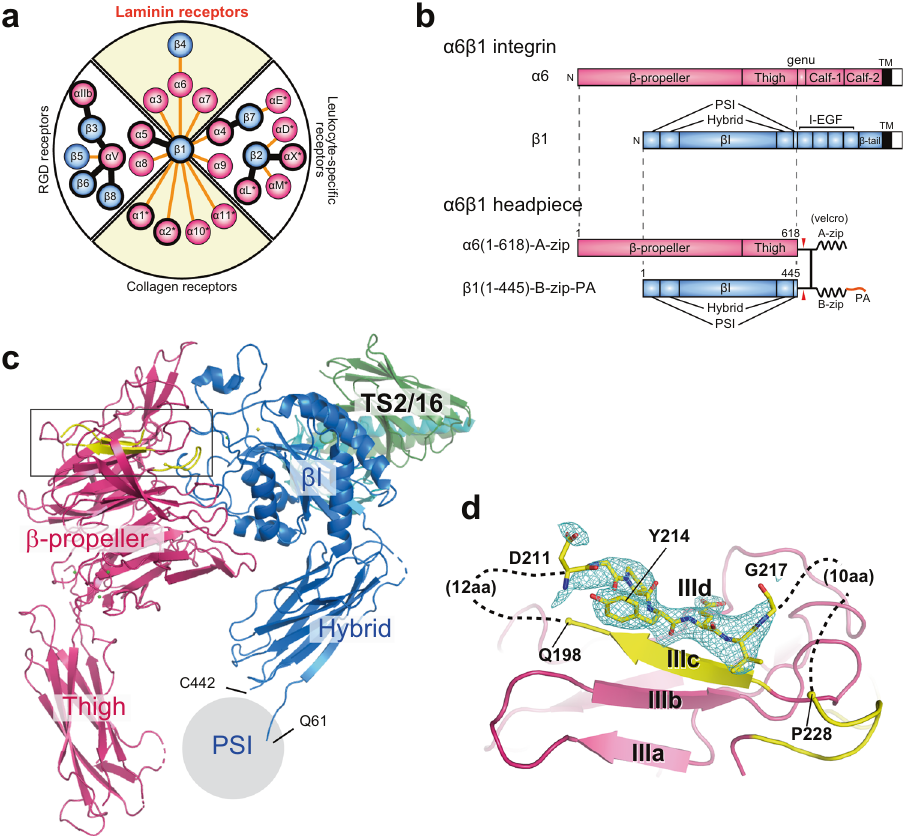
Fig. 1 Crystal structure of the α 6 β 1 integrin headpiece in complex with TS2/16 Fv-clasp. a Integrin α / β pairs and classi fi cation. 18 α subunits (red circles, with the α I domain-containing ones indicated by asterisks) and 8 β subunits (blue circles) found in human forming 24 heterodimeric pairs are represented by the α - β connecting lines. Integrin subunits or heterodimers with at least partial ectodomain structures determined are denoted by thick circles. Each heterodimer falls into one of the four distinct classes. Modi fi ed from the Fig. 1 of ref. 1 . b Domain organization of α 6 β 1 integrin and design of the α 6 β 1 headpiece construct used for the structural analysis. c Ribbon presentation of the overall structure. Integrin α 6 and β 1 subunits are colored in hot pink and sky blue, respectively, and TS2/16 V H -SARAH and TS2/16 V L -SARAH composing TS2/16 Fv-clasp are in green and cyan, respectively. The location of the PSI domain (not included in the model) is denoted by gray circle, with the boundary residues (Q61 and C442) labeled. d An expanded view of the blade III β -sheet of the α 6 subunit- β -propeller. The region indicated by a rectangle in ( c ) containing the X1 region (yellow) is shown with an F o - F c electron density map corresponding to the outermost strand (IIId) contoured at 3.0 σ . The modeled heptapeptide 211 DGPYEVG 217 fi tted in the map is also shown as stick